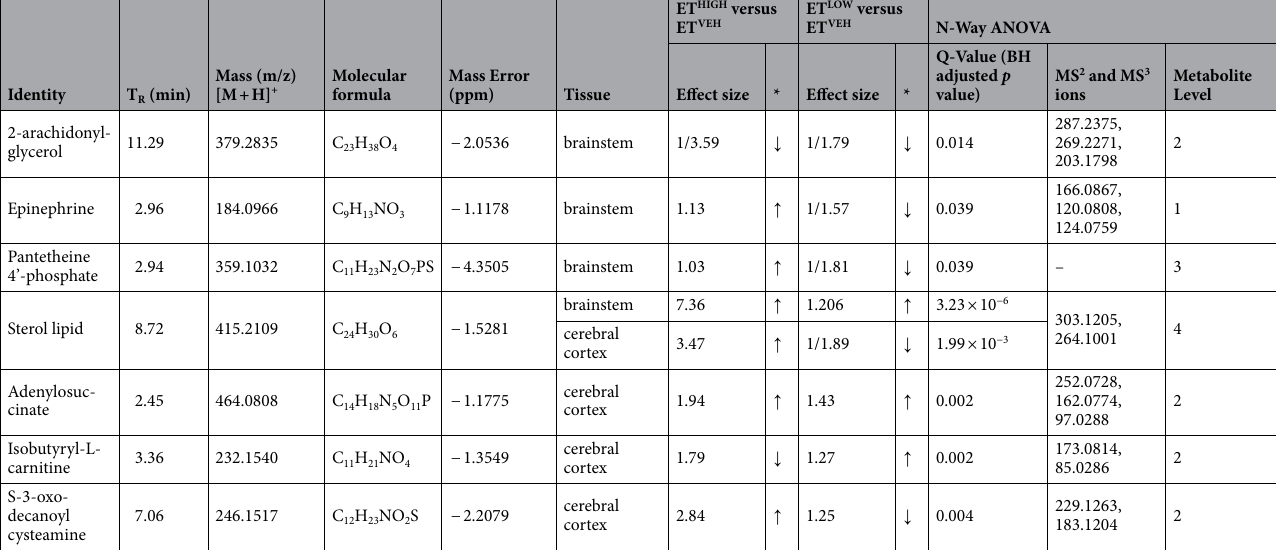
Table 1. Summary of identified metabolites altered in the brain tissue in mice treated with ergotamine compared to vehicle control. * ↑ = Up-regulated, ↓ =